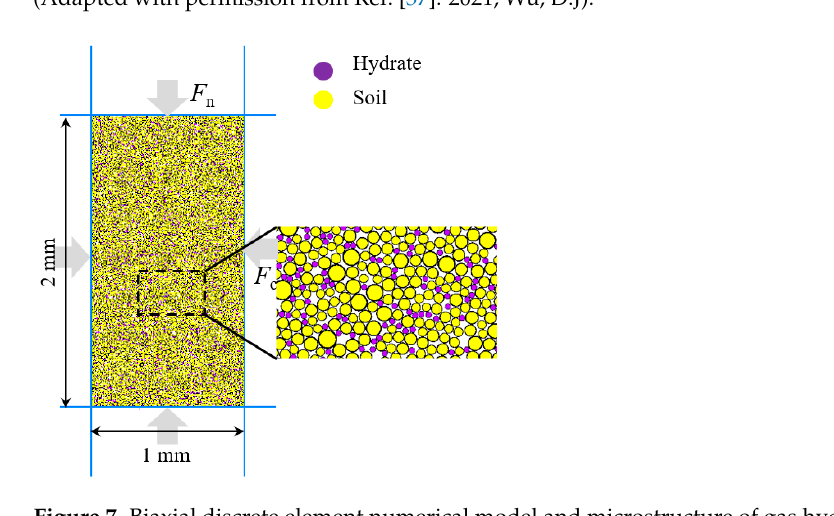
Figure 8. Comparison of discrete element simulation and experimental results of shear test of natu- ral gas hydrate deposits. (Adapted with permission from Ref. [37]. 2021, Wu, D.J). Table 1. Characteristic parameters of sand, hydrate particles, and walls in the model. Round Particles